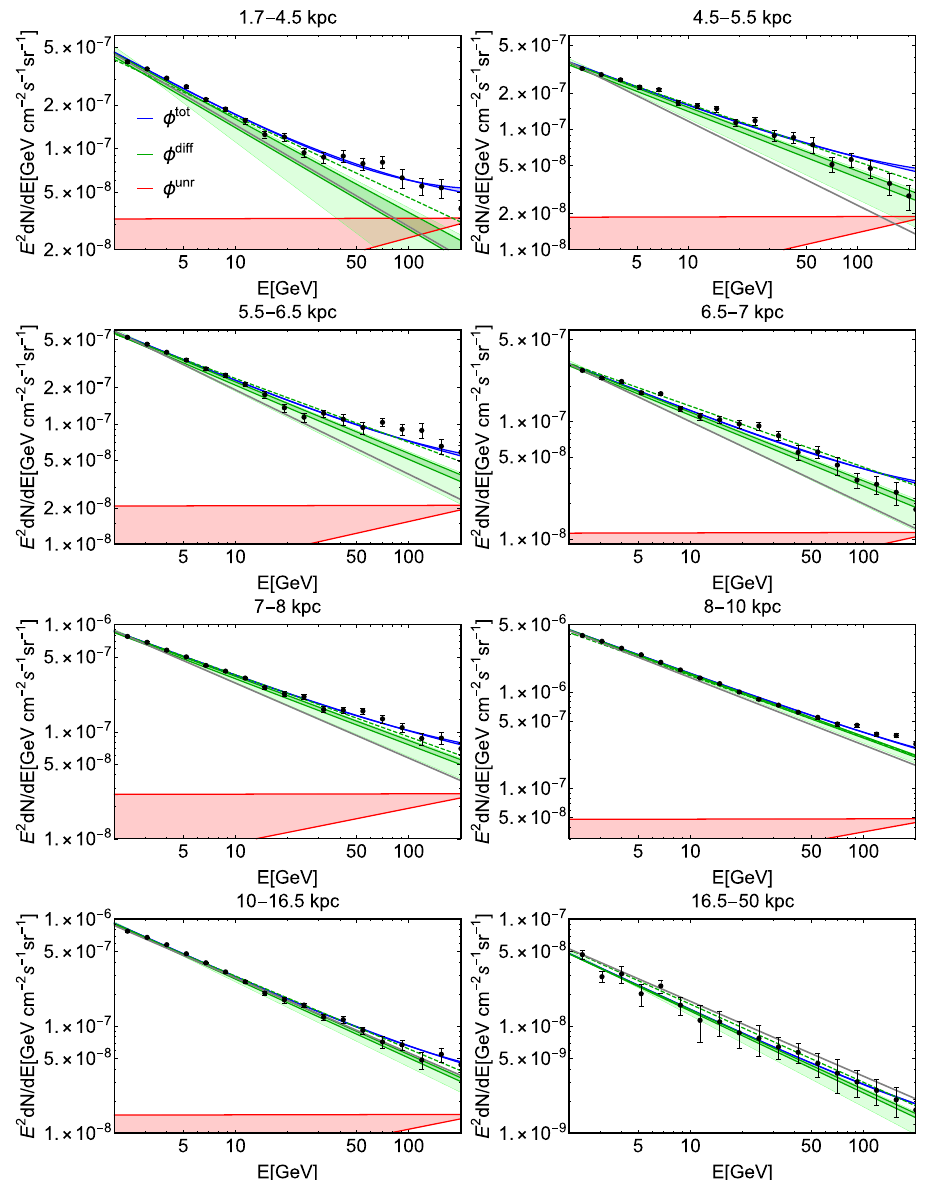
Fig. 1 The diffuse gamma-ray emission as a function of energy in different galactocentric rings. Black data points show the total diffuse γ -ray emission associated with interstellar gas measured by Fermi-LAT in each galactocentric ring, the error bars represent the statistical error see Pothast et al. 2 for details. The red bands represent the predicted contribution of unresolved TeV pulsar wind nebulae for α = 1.8, E 0 = 0.8 TeV, β TeV = 2.4 and R Φ ranging between 250 and 1500. Green lines show the diffuse cosmic ray emission inferred by fi tting the data with (solid) and without (dashed) including the pulsar wind nebulae contribution. The dark green bands show the systematic error produced by variations of the fl ux ratio R Φ . Light green bands show the total systematical uncertainty obtained when E 0 and β TeV are also allowed to vary. Blue lines represent the total gamma fl uxes predicted as a function of the energy for α = 1.8, E 0 = 0.8 TeV, β TeV = 2.4 and R Φ ranging between 250 and 1500. The gray lines show a power-law with an index of 2.7 for